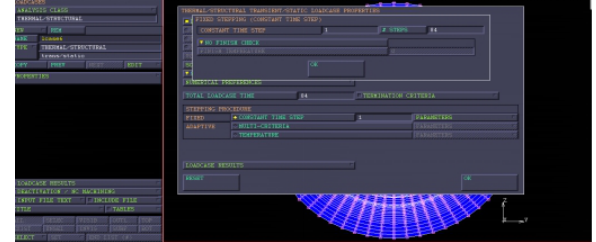
Figure 8. Setting pattern of weld conditions